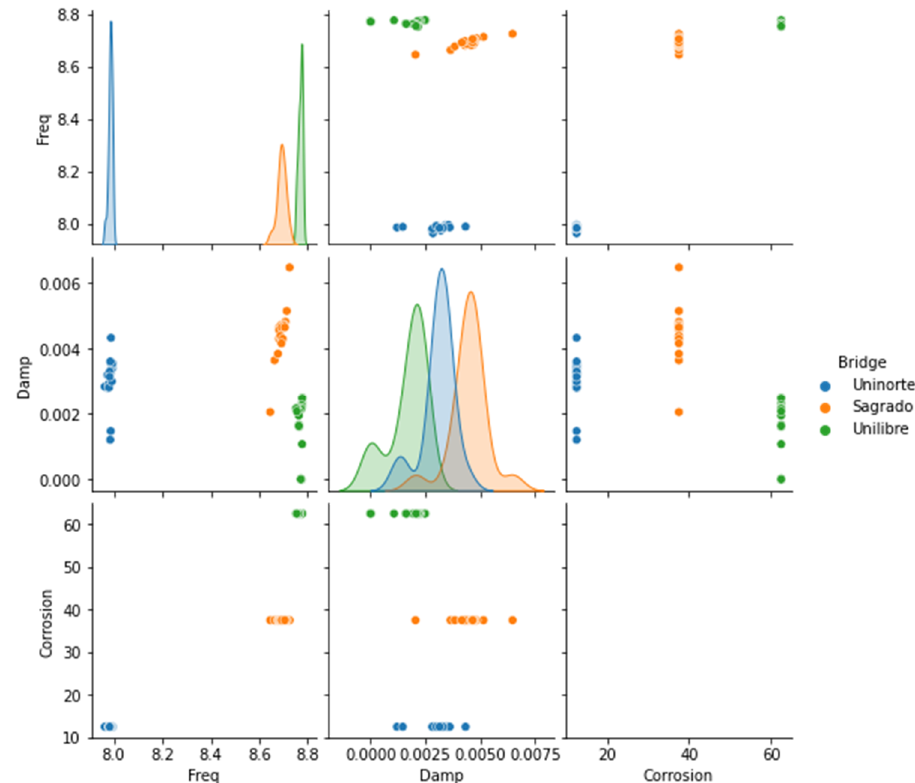
Figure 23. Relationship between the dynamic parameters and corrosion grade.